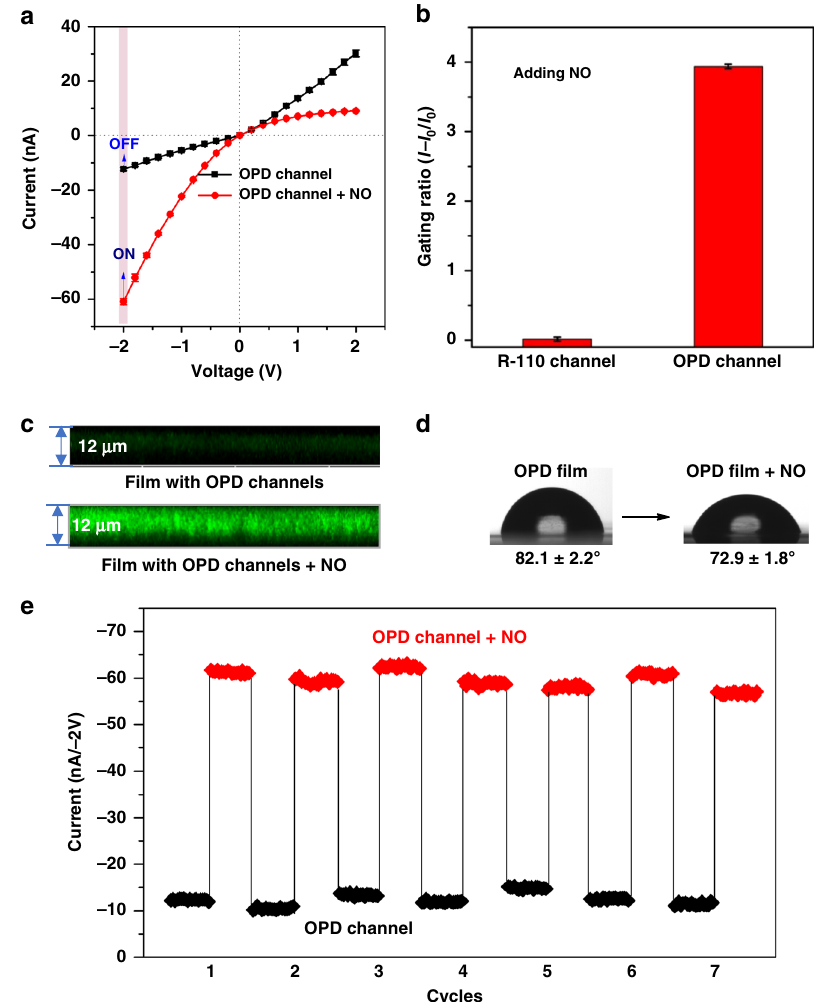
Fig. 3 NO-driven ionic recti fi cation and gate. a I − V responses of the OPD channel in the absence and presence of NO; b NO-driven ion gating ratio (Rg), which shows that the OPD channel was opened by NO; c LSCM observation of fl uorescence signals of the OPD-modi fi ed nanochannel in the absence and presence of NO; d photographs of the water droplet shape on the PET fi lms in the absence and presence of NO; e stability and switchability of the NO- responsive ionic gate. OPD o -phenylenediamine, LSCM laser-scanning confocal microscopy, PET polyethylene